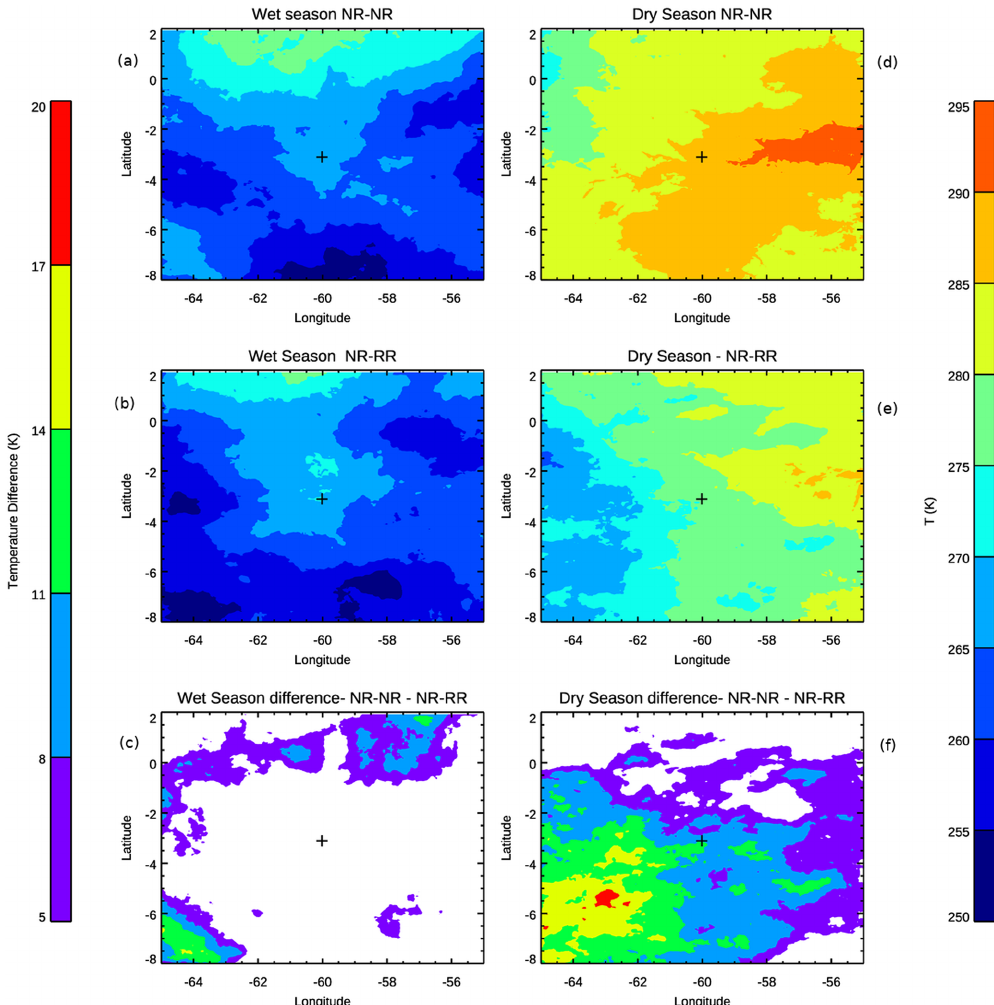
Figure 12. Mean GOES 10.4µm brightness temperature fields and absolute differences from 20:00 to 08:00LT for dry and wet seasons and NR–NR and NR–RR transitions. The cross marks the T3 position. Non-significant differences (areas where differences and their standard deviations overlap) are marked in